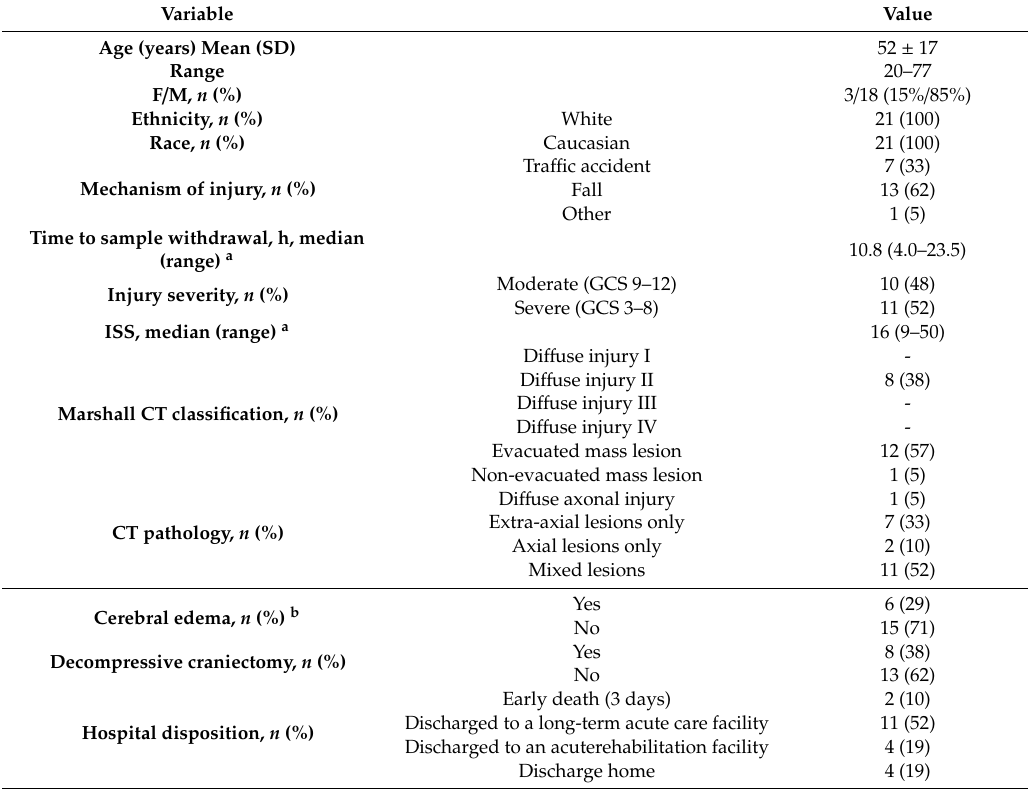
Table 1. Characteristics of 21 patients with moderate to severe traumatic brain injury